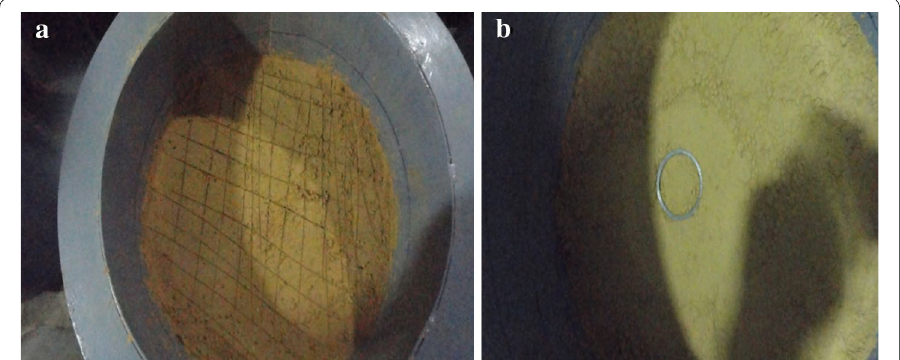
Fig. 4 a Scratching each layer after compaction. b Measurement of soil density